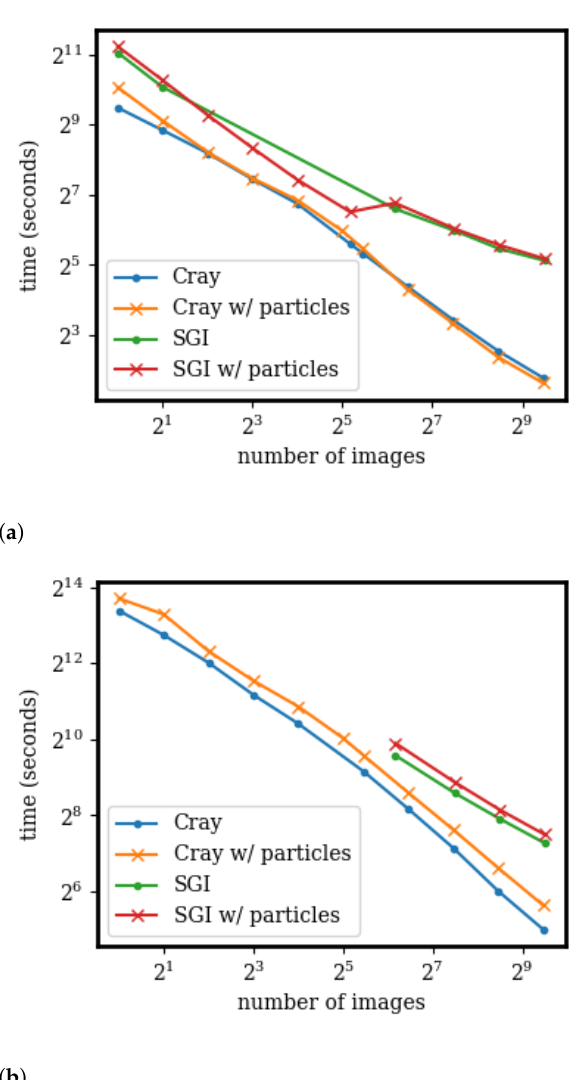
Figure 14. Log-log graphs of the domains of ( a ) grid dimensions 500 × 500 × 30 and ( b ) grid dimensions 2000 × 2000 ×